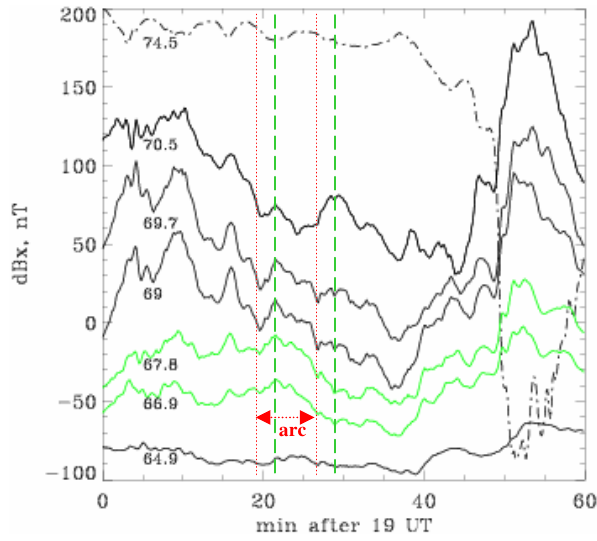
Fig. 1. Variations of magnetic field (north component) recorded Fig. 1 by BRJ, SOR, TRO , KIL, KIR, PEL, RVK magnetometers of IM- AGE network during one hour starting from 19 UT on 19 December 2006. Geographical latitude of each magnetic station is written un- derneath the corresponding observation.